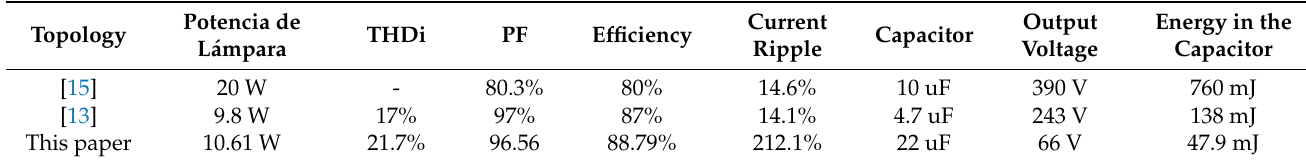
Table 7. Comparison with other reported